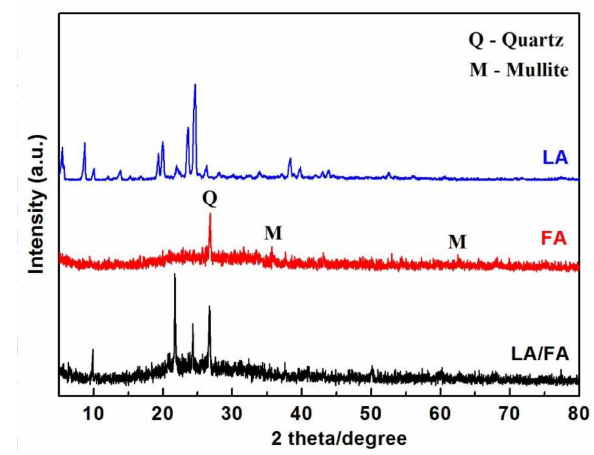
Figure 2. XRD patterns of LA, FA and LA/FA.